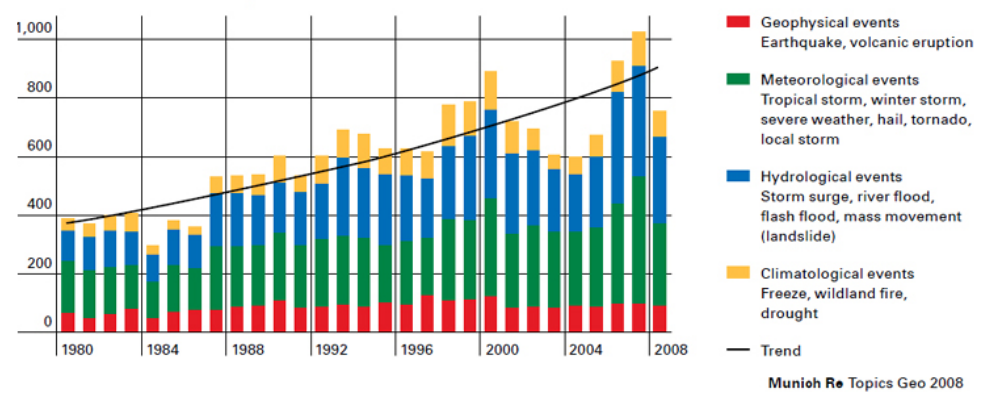
Fig. 1. Number of natural catastrophes since 1980 (Source: Munich Re Group,